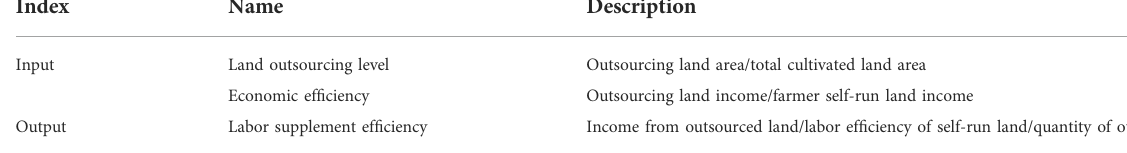
TABLE 1 Input and output indicators of rural land outsourcing ef fi